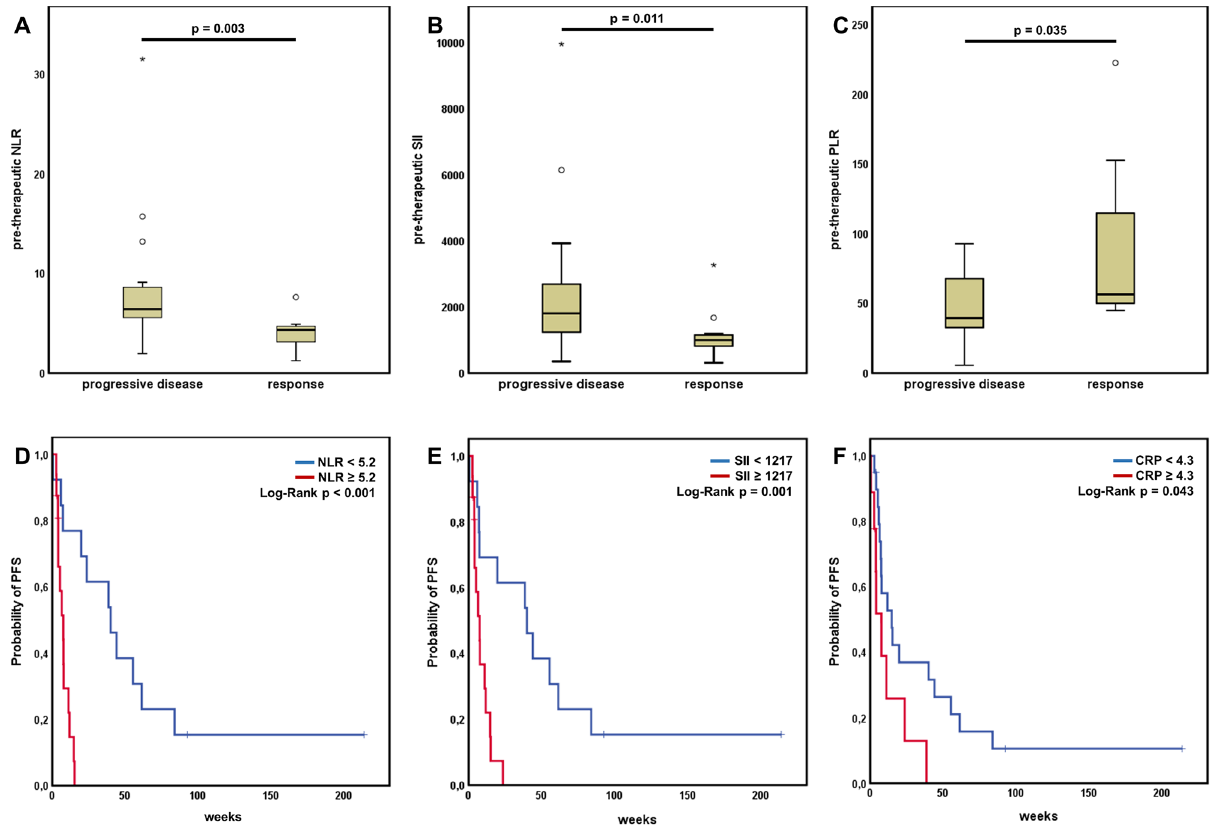
Figure 1. Pre-therapeutic inflammatory scores predict response and survival. Patients with initial response showed significantly lower levels of ( A ) neutrophil to lymphocyte ratio (NLR), ( B ) systemic inflammation index (SII) or elevated levels of ( C ) platelet to lymphocyte ratio (PLR). PFS was significantly longer in patients with lower NLR ( D ), lower SII ( E ) and lower CRP ( F